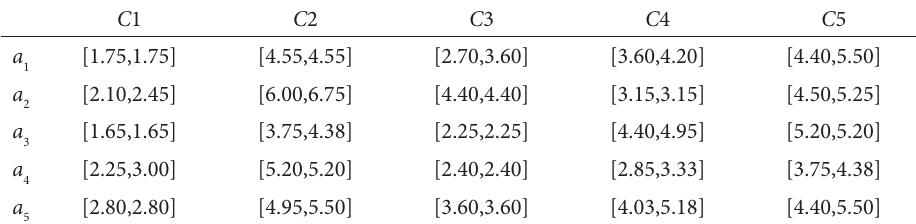
Table 2. The expected values of all criteria values C 1 C 2 C 3 C 4 C 5